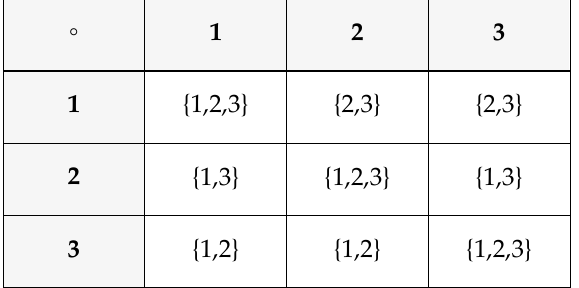
Table 16. The rigid right almost-hypergroup of three